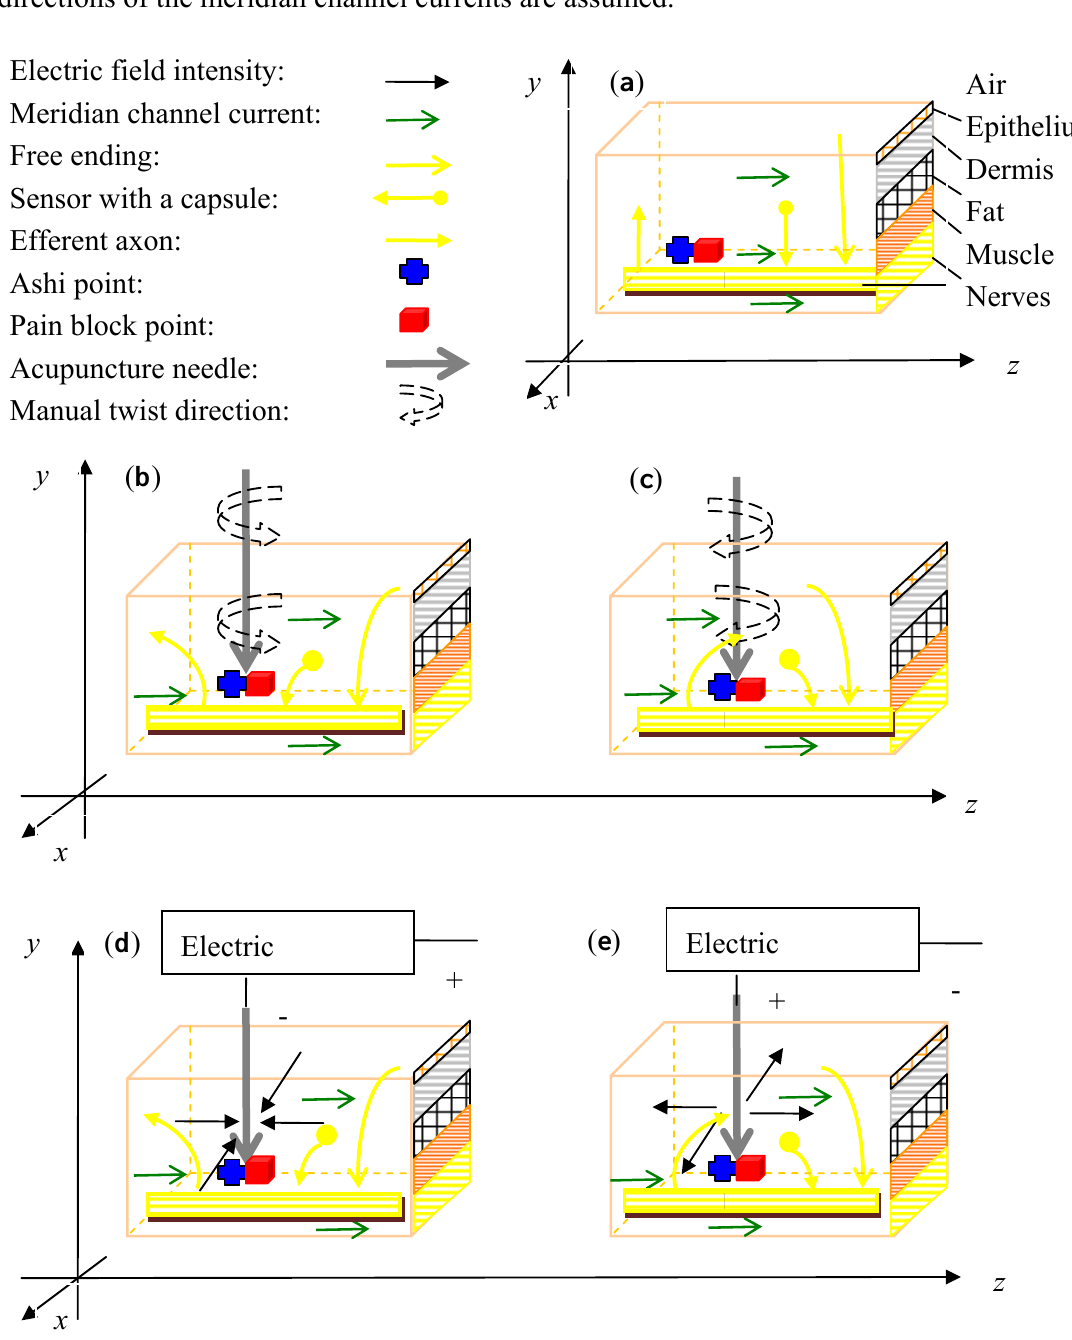
Figure 2. Our models of interactions between acupuncture and nervous sensors at an ashi point. ( a ) No treatment; and treatment with ( b , c ) manual mechanic stimulation; and ( d , e ) automatic electric stimulation. We assume the sensors have net negative charges. The directions of the meridian channel currents are